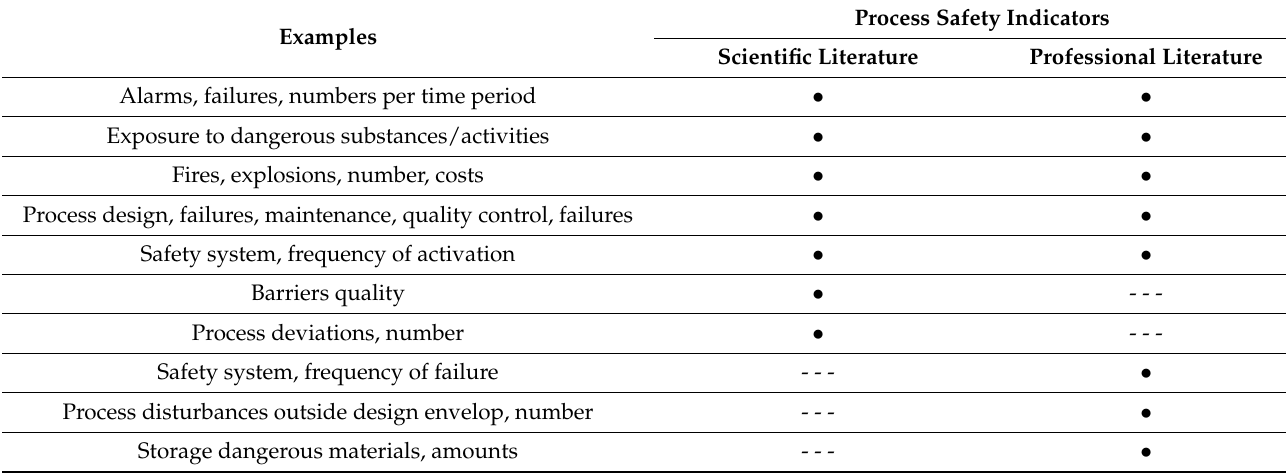
Table 2. Examples of process safety indicators from the scientific and professional literature (Adapted from [12]).